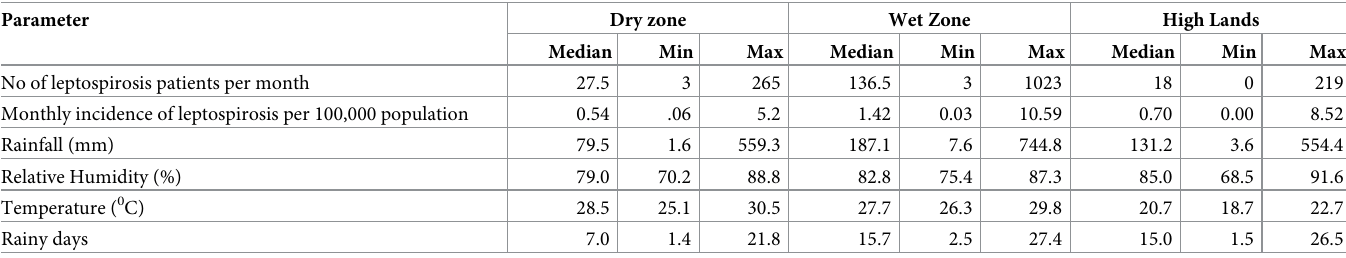
Table 3. Descriptive statistics of the model parameters used to describe the incidence of leptospirosis cases and meteorological variables.